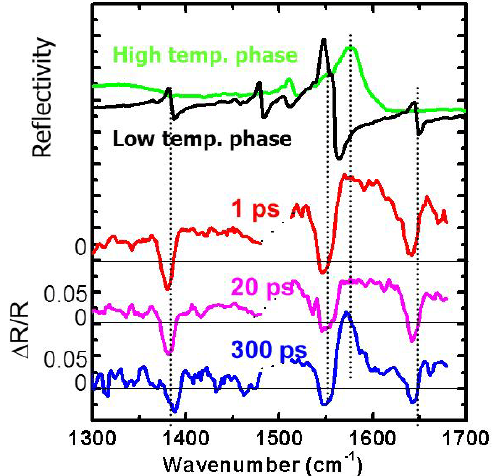
Figure 8. Static reflectivity spectra of (EDO-TTF) phases and high-resolution reflectivity change spectra in C=C-stretching vibrational region [16].